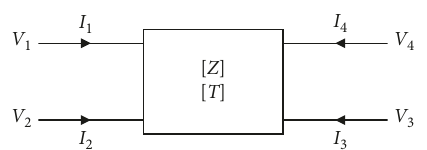
Figure 4: Schematic of current and voltage flow graph for asymmetrical directional